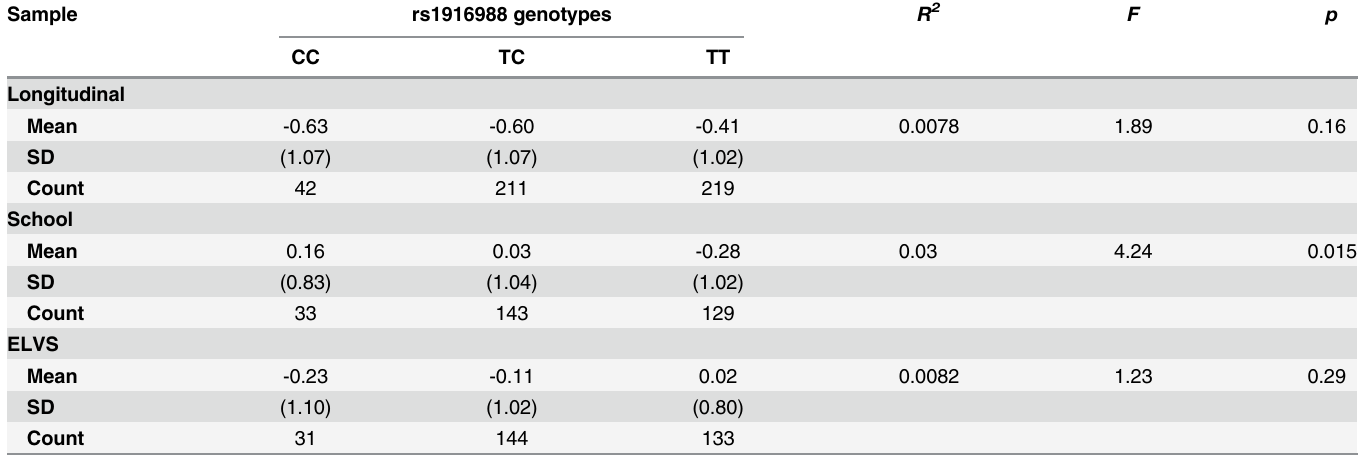
Table 2. Means and standard deviations of language composite scores by genotype at rs1916988.